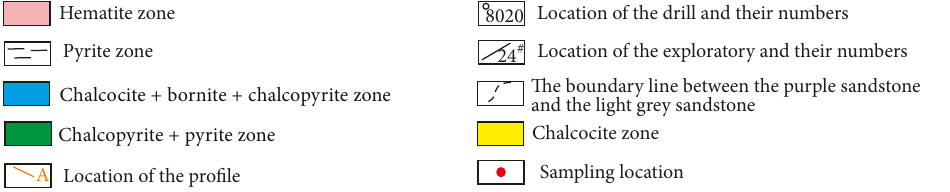
Figure 6: Metal mineral zoning of Dayao copper